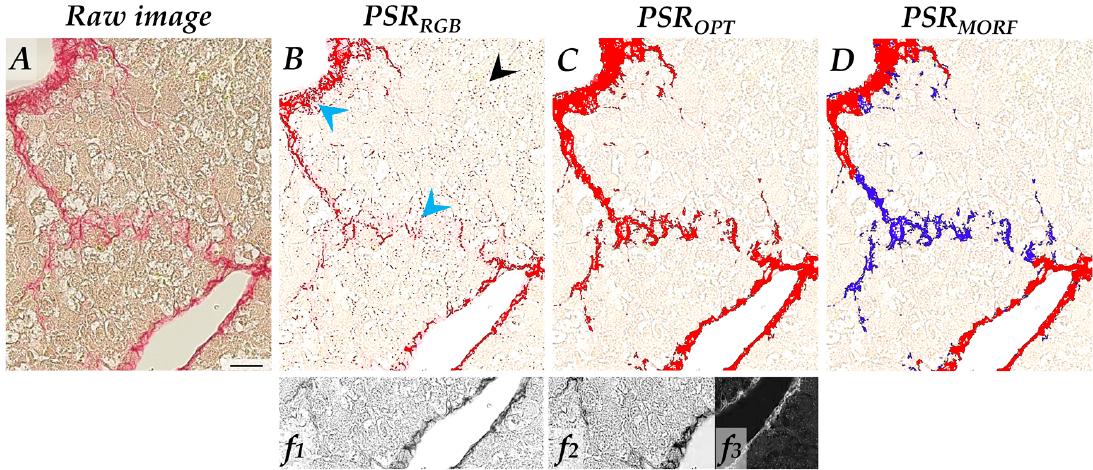
Figure 4. Detection methods of discrete liver fibrosis stained in PSR. ( A ) Native image. ( B ) PSR RGB detection method, using RGB-G filter (insert f 1 ). Staining detection is highlighted in red. Blue arrows: undetected pixels (false negative); black arrow: unsaturated pixels (false positive). ( C ) PSR OPT detection method using optimized filters (inserts f 2 and f 3 ). Staining detection is highlighted in red. ( D ) Optimized detection is used for morphological segmentation (based on fiber density and staining intensity) with algorithm PSR MORF . Compact fibers are labeled in red and scattered fibers are labeled in blue. Refer to Supplementary Materials 2 and 3A for the filters, the detailed procedure, and the dynamic ranges of sensitivity. Scale bar = 50 μ m.